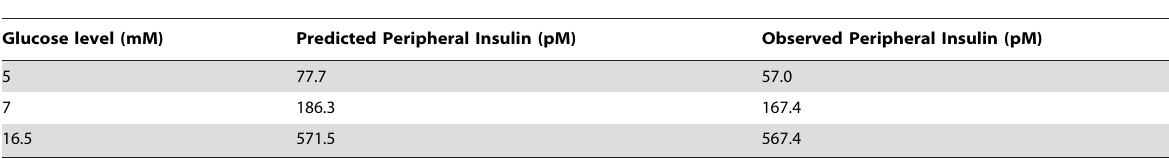
Table 3. Comparison of predicted dose-response and observed dose-response values. 1